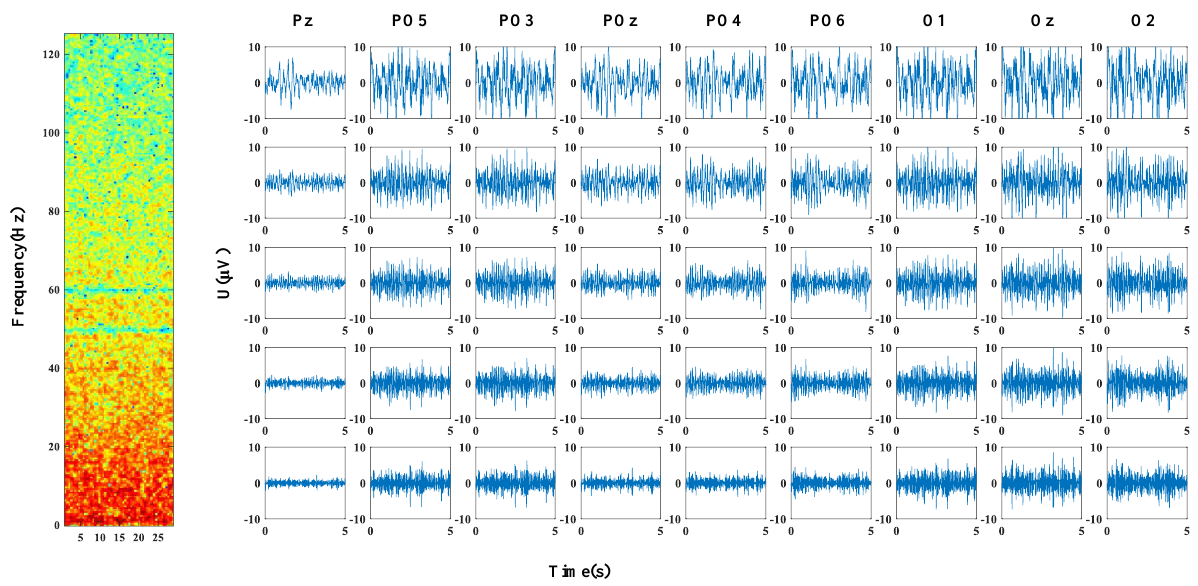
Figure 7. Time–frequency diagram and subband decomposition.